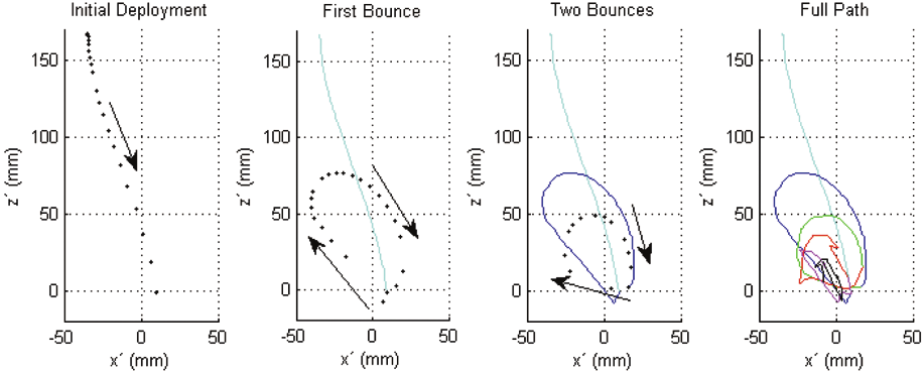
Fig. 6. The path data for a typical deployment with low lateral momentum, separated by bounces, is shown in the flattened cylindrical coordinates.